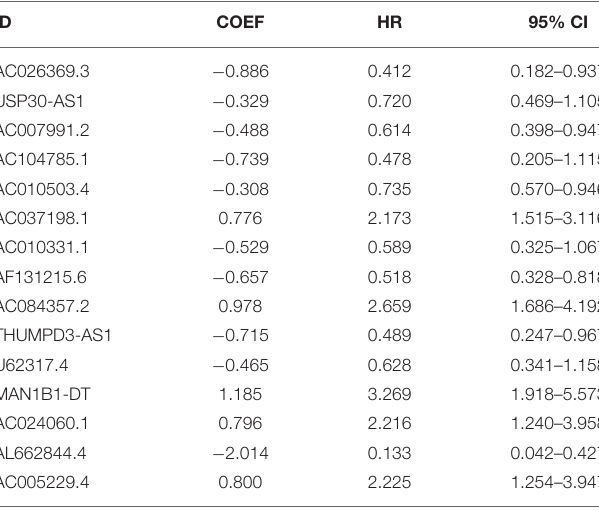
TABLE 2 | Multivariate cox analysis revealed 15 autophagy lncRNAs that were significantly associated with BC